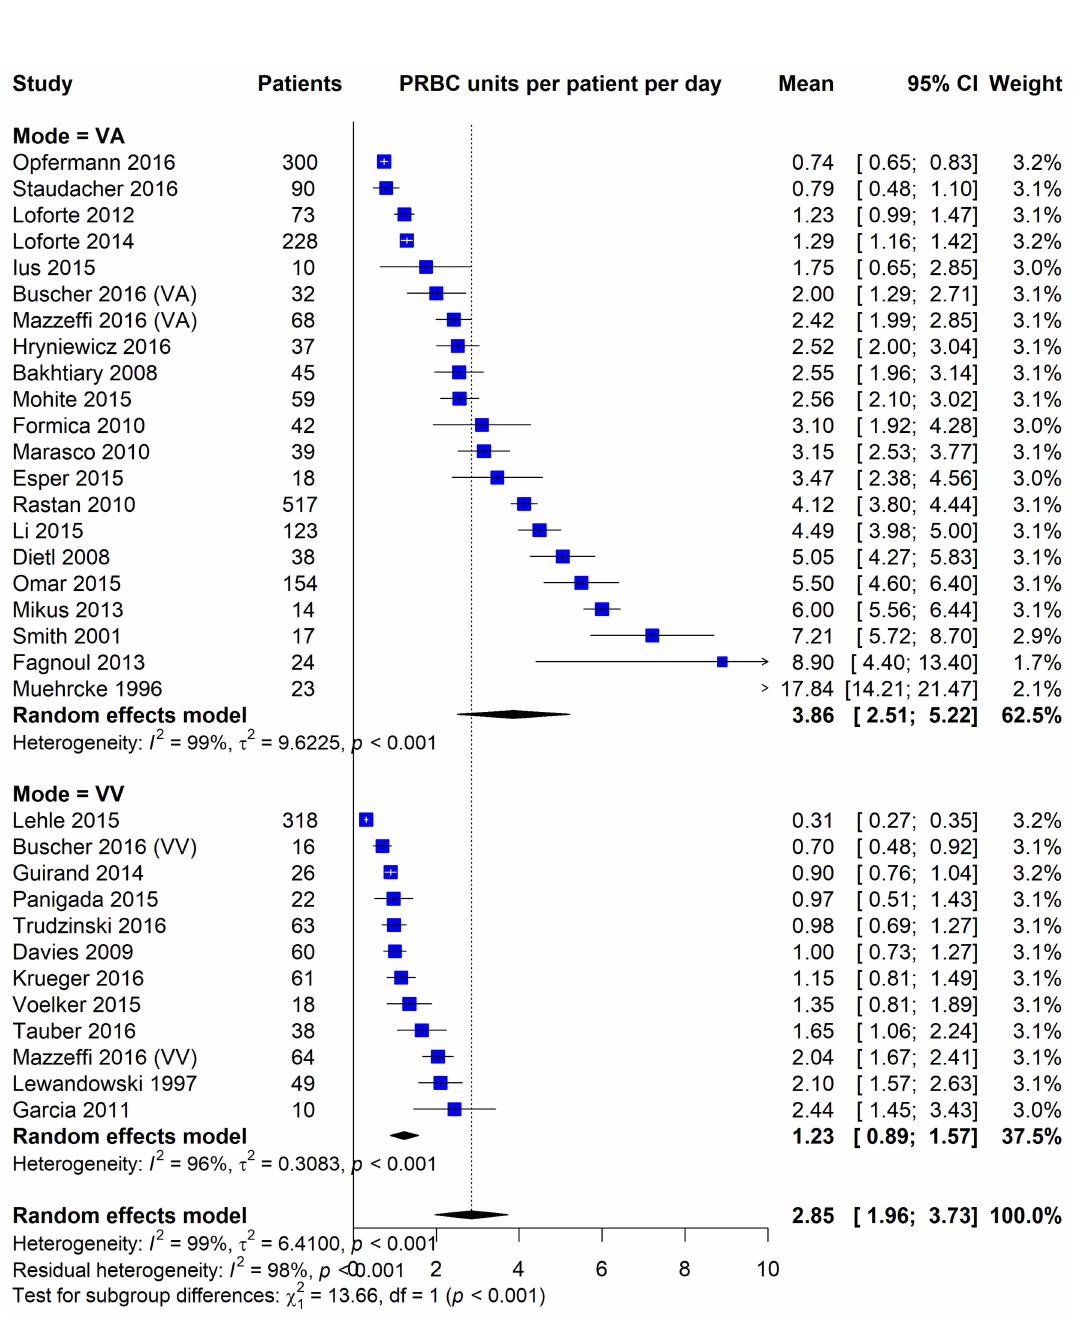
Figure 3. Forest plot comparing VV and VA